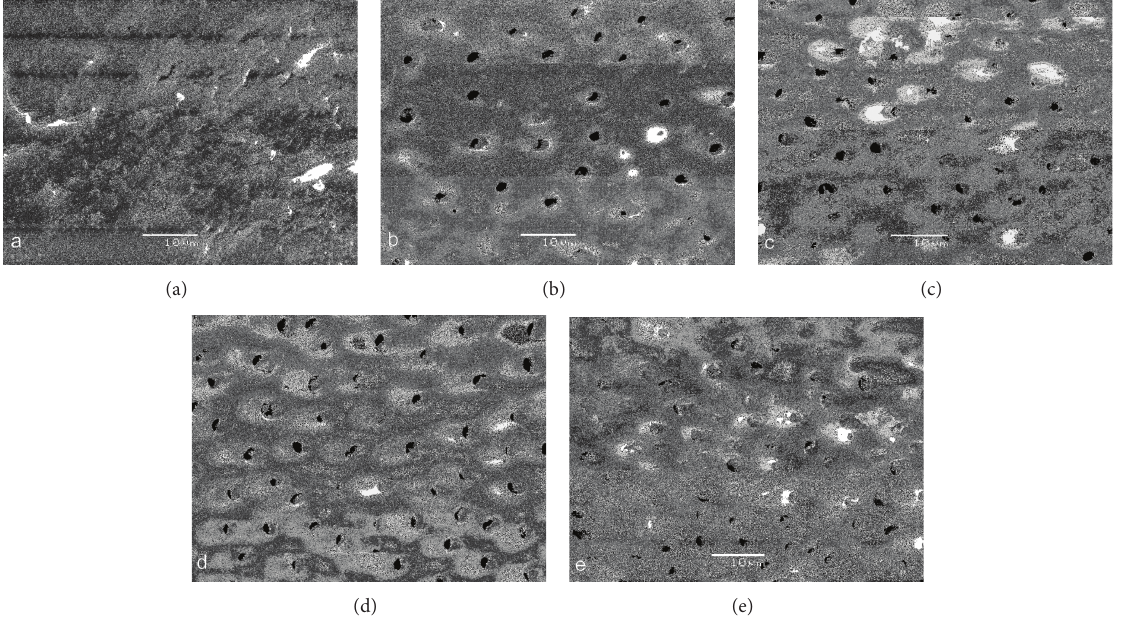
Figure 3: Photomicrographs of root canal wall in each group after final cleaning protocols (original magnification: 2000x; scalebar is 10 𝜇 m). Images (a)–(e) show canal walls at 1, 3, 6, 8, and 12 mm from the apex. In groups 2 and 7, open tubules and removal of smear layer were clearly observed at all sites except at 1mm. White areas of erosion around the dentinal tubule openings were seen. (a) is at 1mm from the apex and (e) is at 12 mm from the